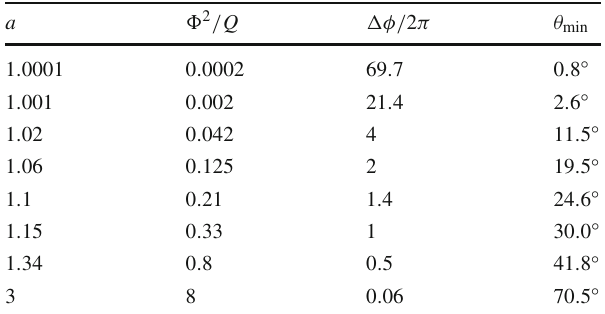
Table 2 Characteristics of the spherical photon orbits with zero energy in Fig.